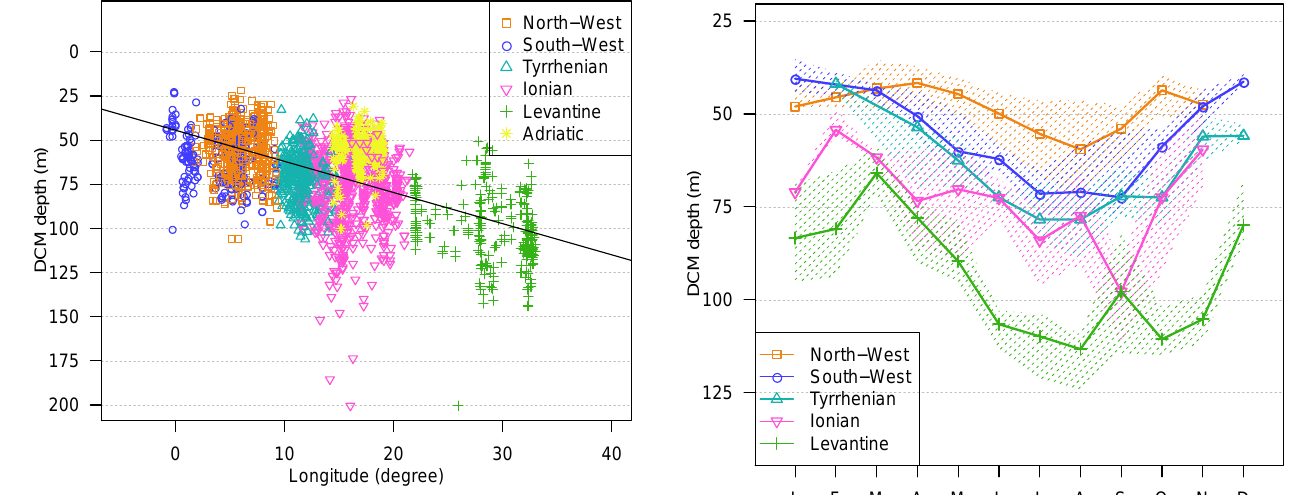
Figure 6. DCM depth as a function of longitude. DCM depths were computed only on profiles of the DCM standard shape (see Sect. 2.3 for an objective definition of DCM shape). Black line represents the linear model between the DCM depth and the longitude. Its slope is 1.6m per degree of longitude.